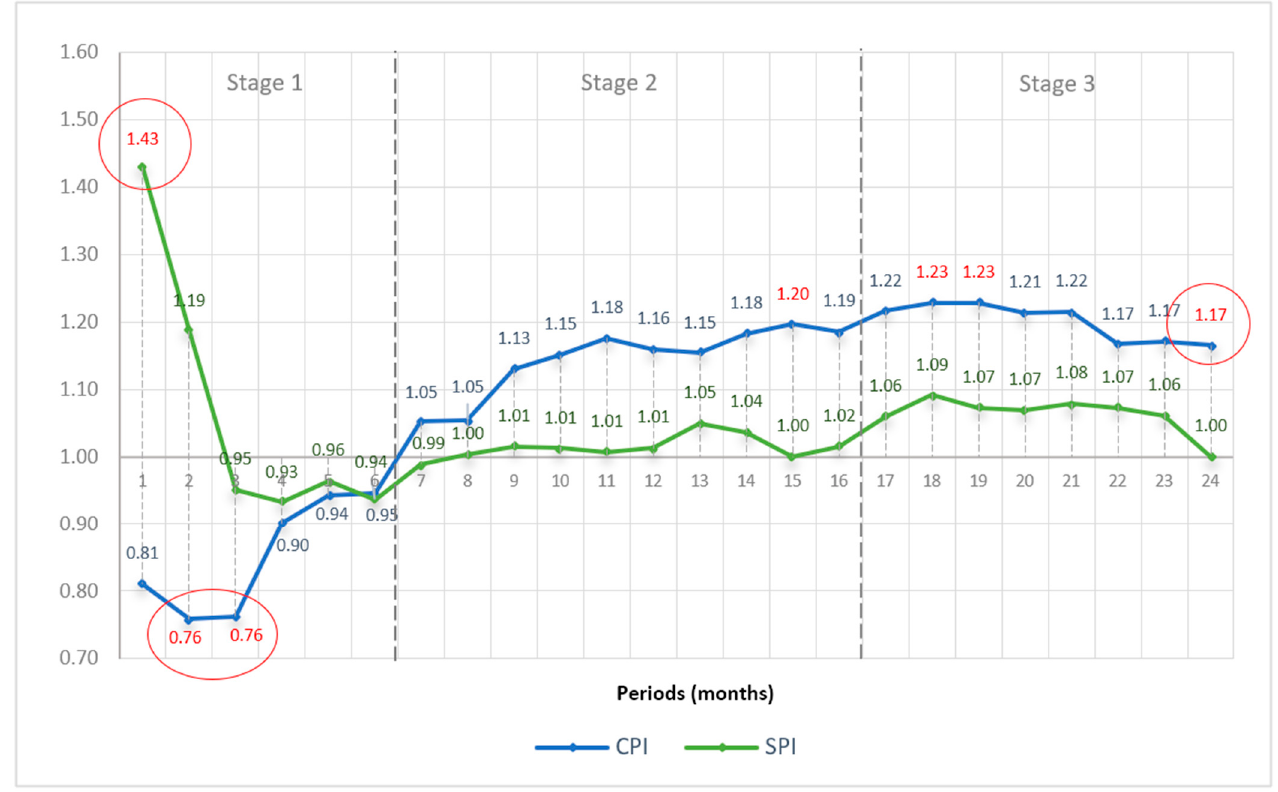
Figure 7. CPI and SPI performance indexes: Project 002 (source: Proaño-Narváez).